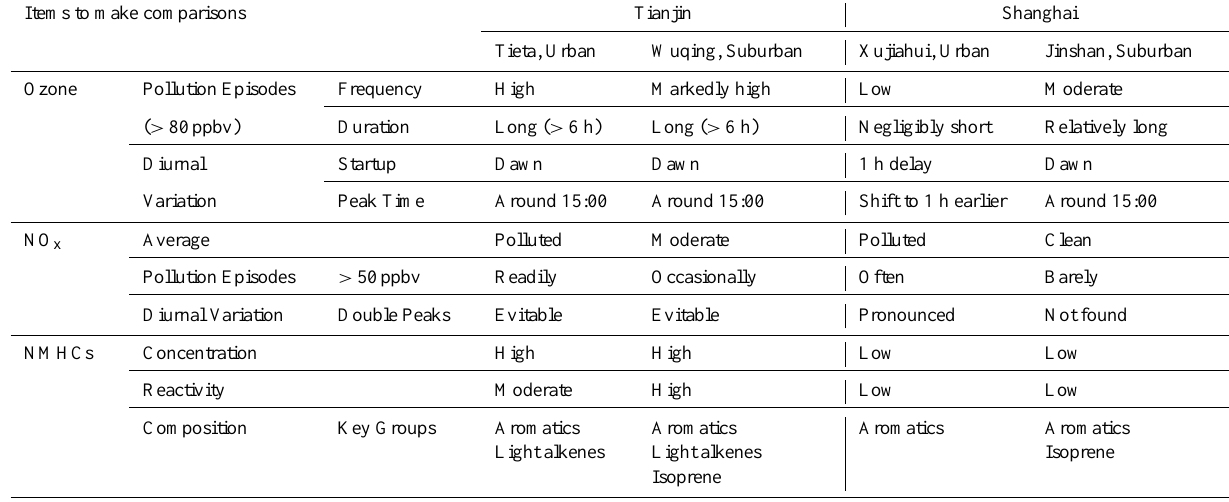
Table 3. A summary for comparisons of ozone, NO x and NMHCs attributes in the four locations. Items to make comparisons